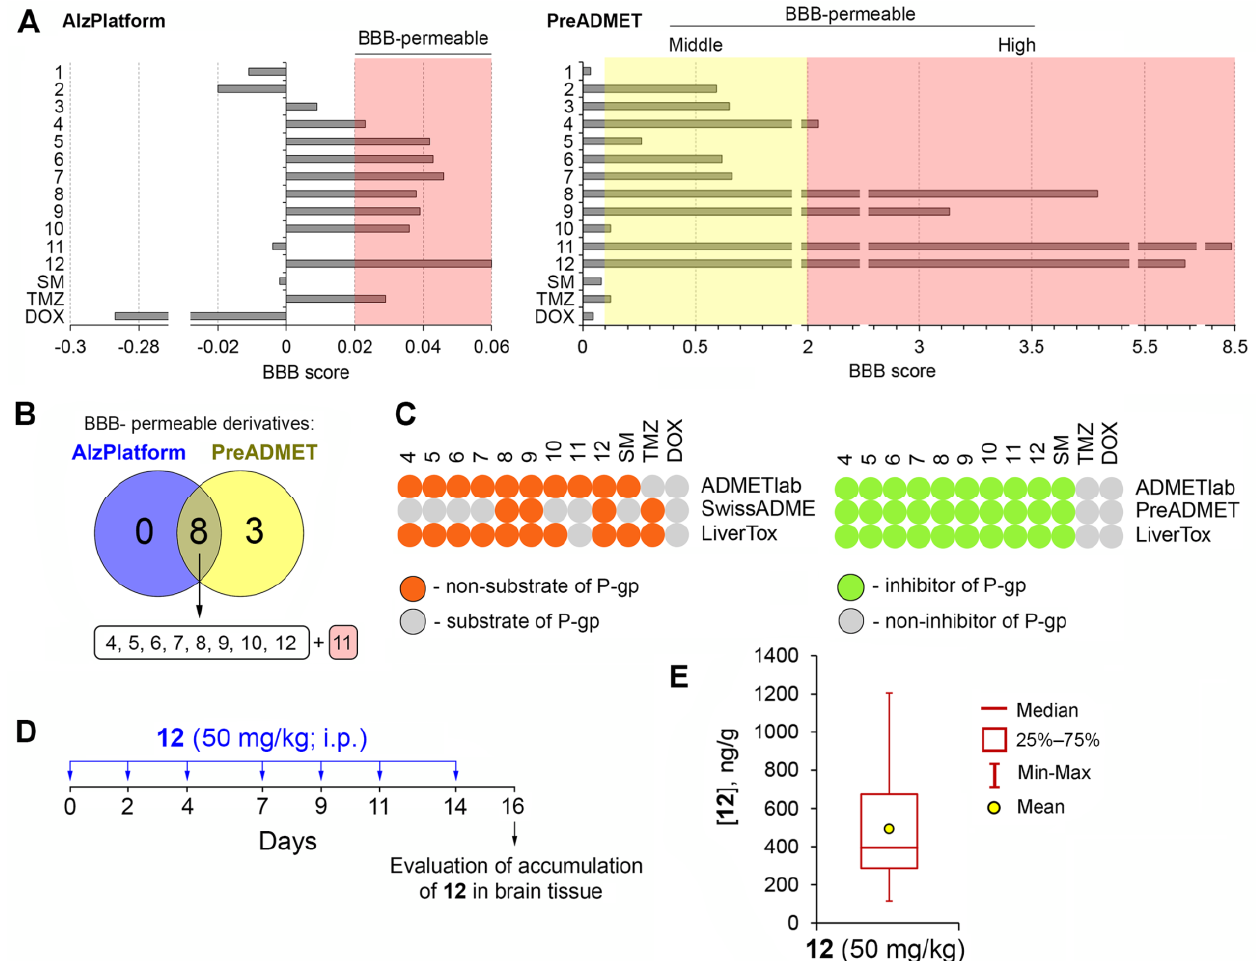
Figure 3. In silico prediction of brain permeation of novel soloxolone amides and experimental validation of BBB permeation by 12 . ( A ) Analysis of the probable permeability of novel compounds across the blood–brain barrier (BBB), using two independent chemoinformatics tools, namely, AlzPlatform and PreADMET. The colored areas involve BBB scores, indicating the probable ability of compounds to successfully pass the BBB. Temozolomide (TMZ) and doxorubicin (DOX) were used as reference drugs characterized by high and extremely low brain permeation, respectively.